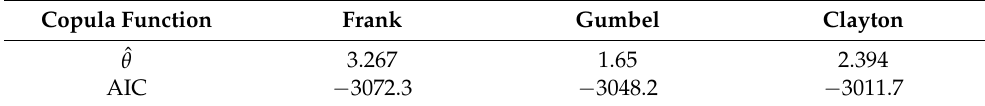
Table 4. The AIC value of Frank was the smallest, indicating that the goodness-of-fit was much better. Table 4. AIC values of each Copula function.